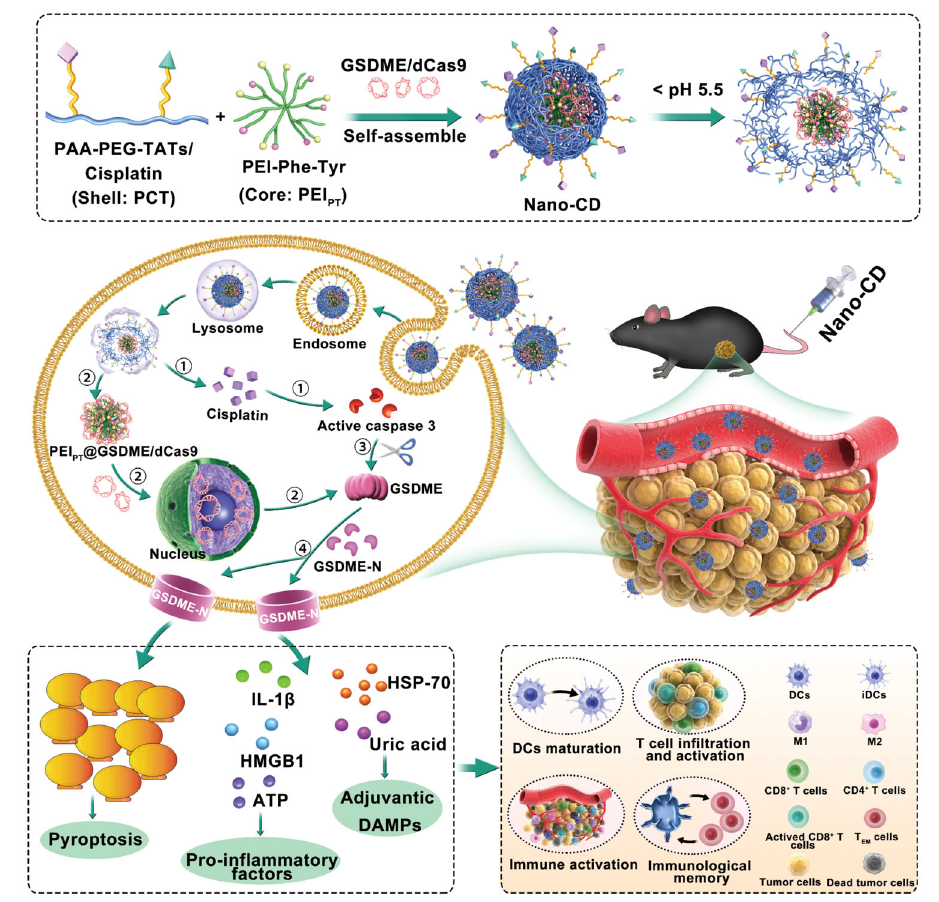
Fig. 1 | Work fl ow of cooperative Nano-CD scaffold. A cooperative Nano-CD scaffoldwasdesignedtoinitiaterobustanti-tumorimmuneresponsesthroughself- supplyof pyroptoticprotein.Uponcellularinternalization, Nano-CDprotectedthe components from lysosome degradation and realized hierarchically release of cisplatin and CRISPR/dCas9 plasmid triggered by endosomal acidic conditions. Owing to the modulation of CRISPR/dCas9, endogenous GSDME protein supplied